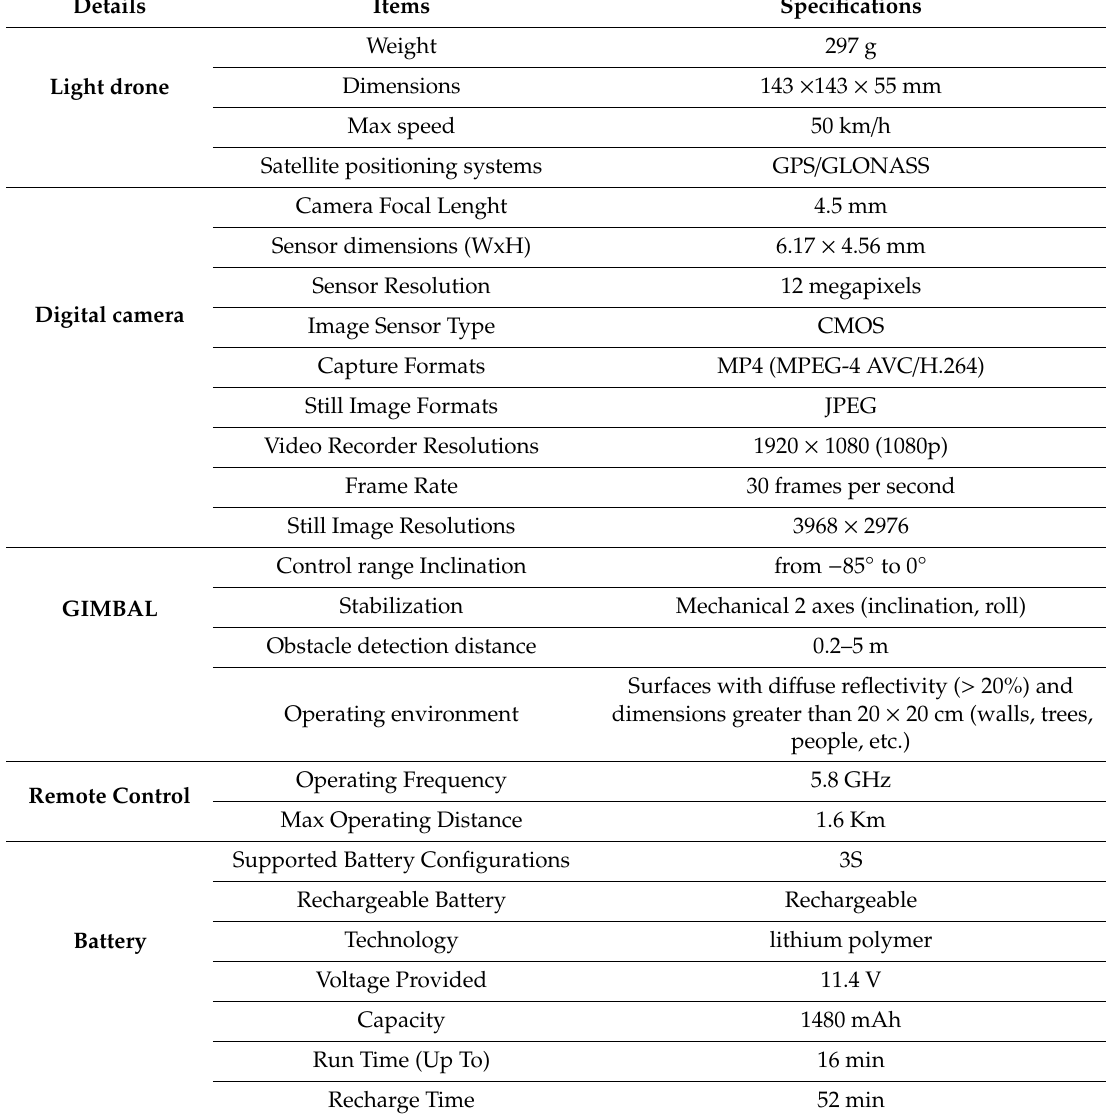
Table 1. Specifications of the Unmanned Aerial Vehicle (UAV) DJI ™ SPARK ™ .